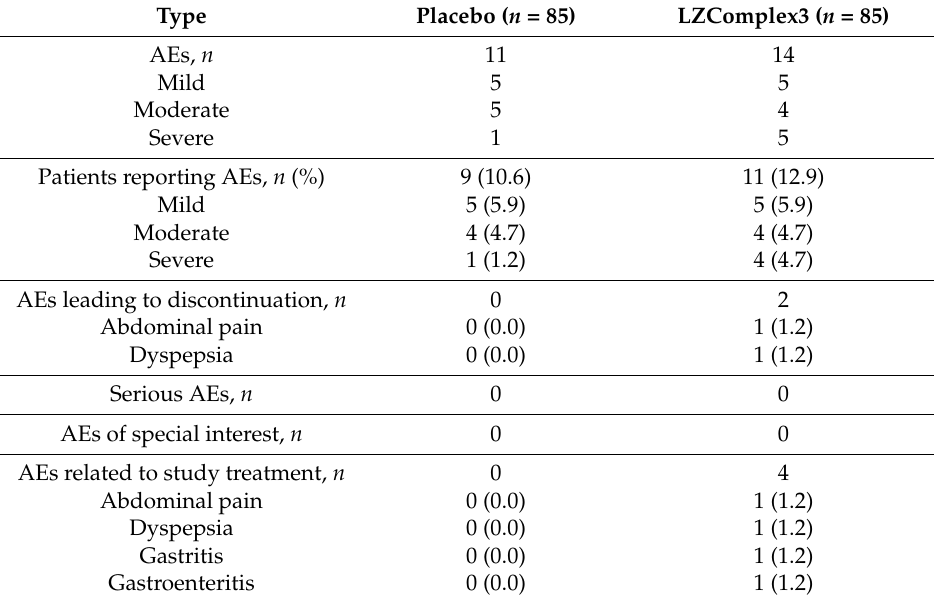
Table 5. Summary of adverse events (AEs) reported during the treatment period (safety